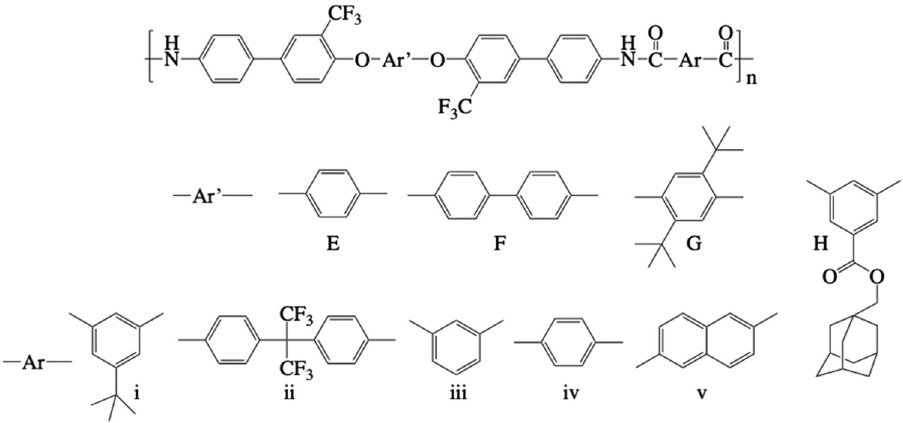
Figure 11: Di ff erent structural variations to modify the polyamides ( 75 – 78 ) .